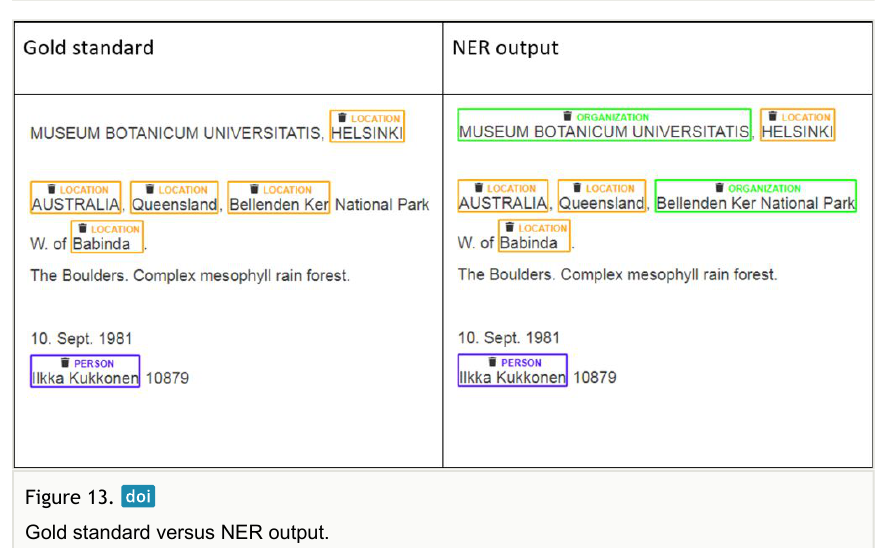
Figure 12. An example of a specimen label.